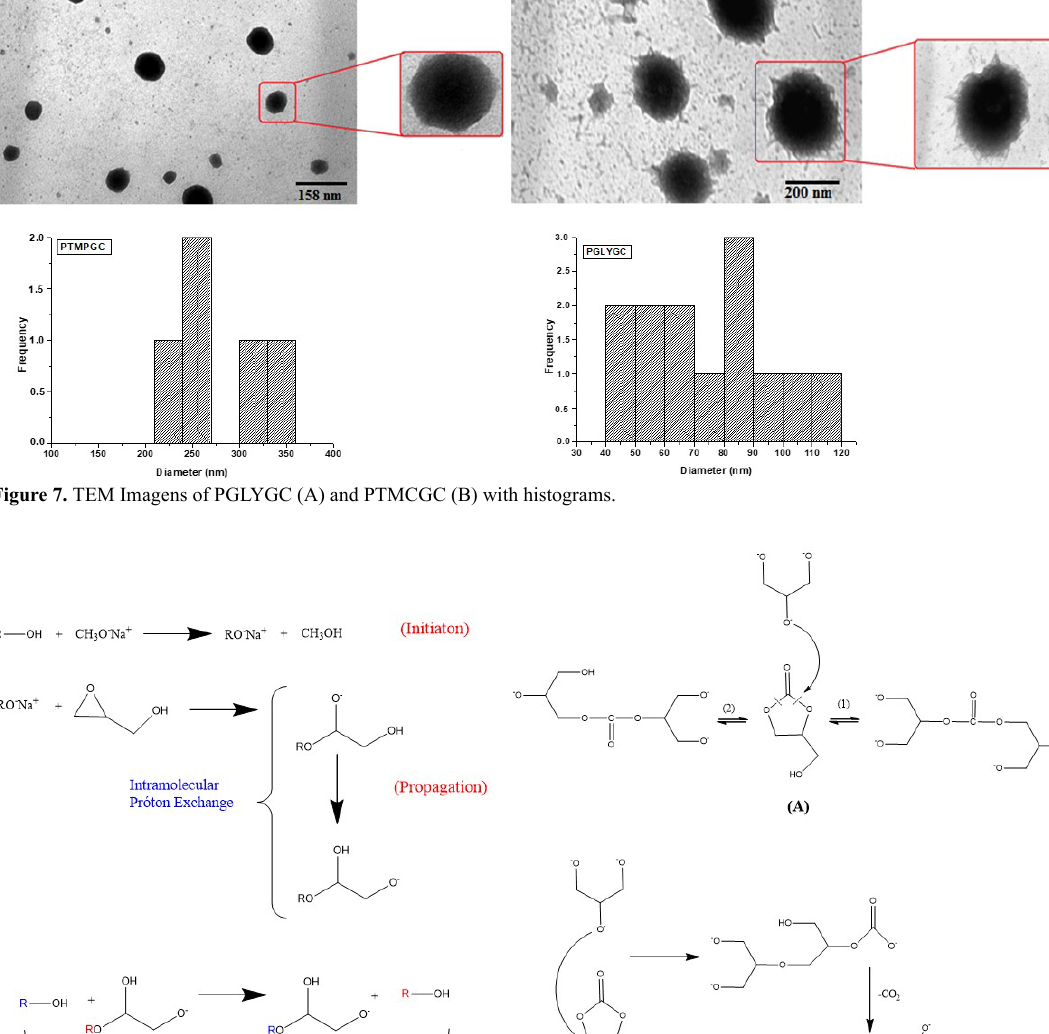
Figure 8. Mechanism of the anionic Polymerization of AB carbon atom attacked. are used, as they allow to control the concentration of active sites in polymerization. The literature showed that only 10% of the hydroxyl group deprotonate is enough to initiate the polymerization process. This control leads to the growth of all chain ends, as well as the control of molecular weight and narrowing of the polydispersity 25